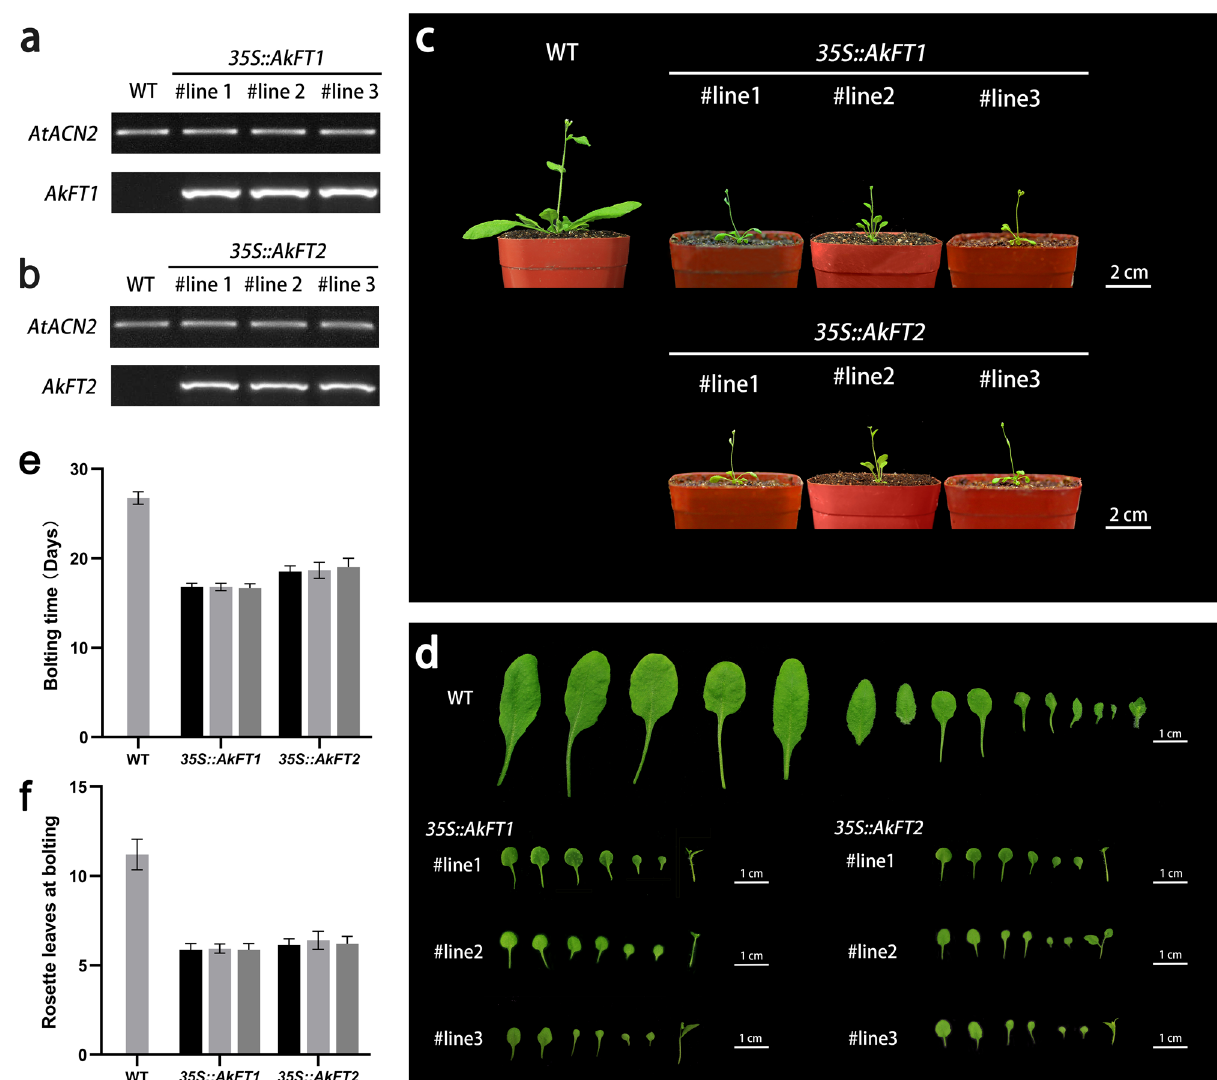
Figure 5. Overexpression of the AkFT genes in A. thaliana. ( a , b ) Semi-quantitative PT-PCR analysis of the AkFT genes in WT and transgenic plants. ( c , d ) Phenotypic observation of flowering in WT and transgenic plants. ( e , f ) Flowering time statistics in WT and transgenic plants. When the bolting length reached 1 cm, it was recorded as the beginning of bolting. The number of rosette leaves per plant during bolting was counted, n ≥